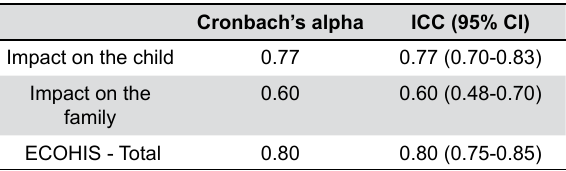
Table 1- Answers internal consistency according to the variance of each item and to Cronbach’s alpha